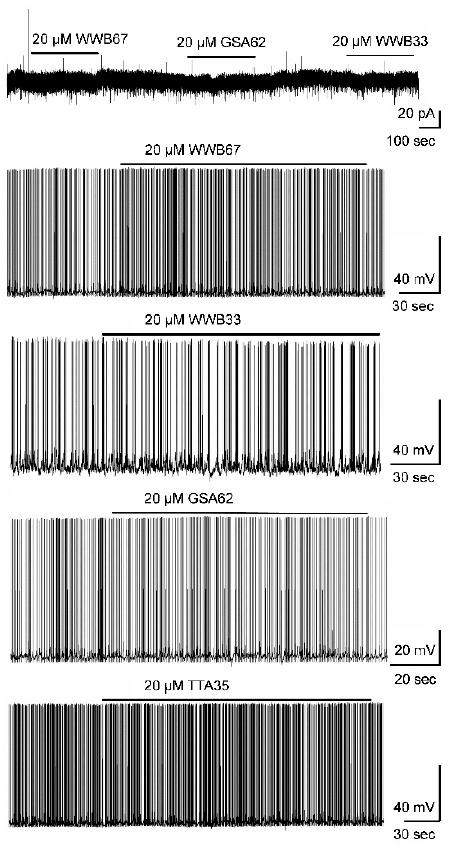
Figure 4. Effects of N-benzamide enaminones on membrane currents in mitral cells. Bath application of novel enaminones to test the effect on membrane currents and action potential firing in the mitral cells of the main olfactory bulb. None of the enaminones that were tested changed the firing rate or evoked distinct membrane currents. Bars above the representative recording traces indicate the application of an enaminone. WWB33 was originally termed SGA